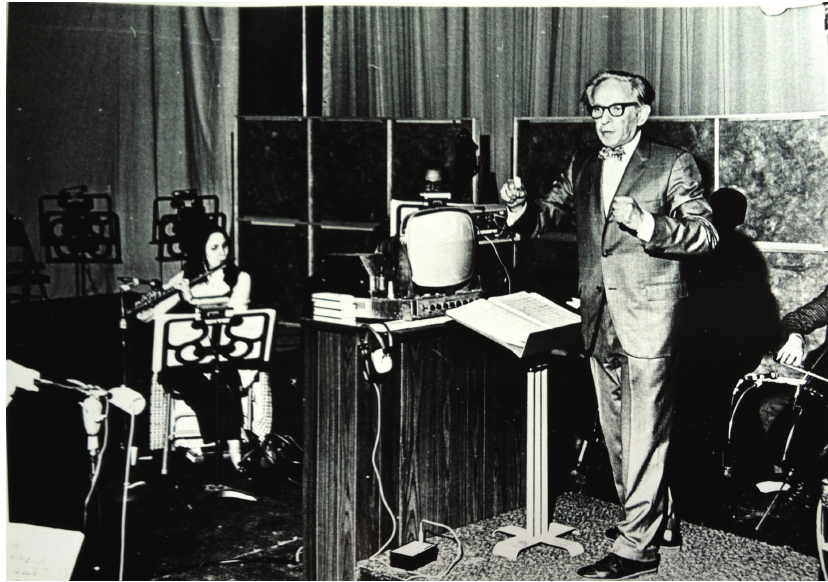
Fig. 4 Kleiner, wearing a bowtie, at the recording session for Battleship Potemkin in 1972. From the private collection of Erik